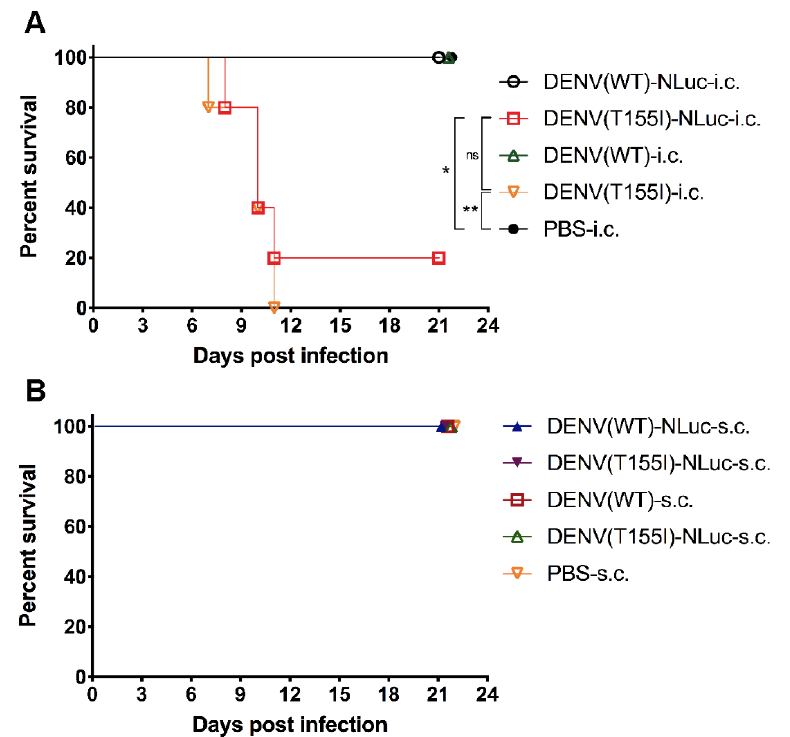
Figure 6. Body weight monitoring of 4-week-old BALB/c mice injected with prototype and reporter DENVs. ( A ) BALB/c mice (n = 5) were injected intracerebrally with 0.03 mL of virus (4.4 lg PFU). ( B ) BALB/c mice (n = 5) were injected subcutaneously with 0.1 mL of virus (5.0 lg PFU) and intracere- brally (right side) with PBS. Body weight of mice was monitored daily.